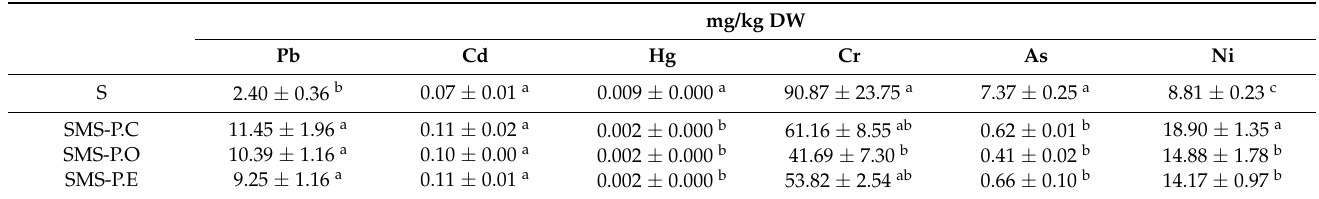
Table 3. Effect of cultivated different variety of mushroom on heavy metal of SMS.